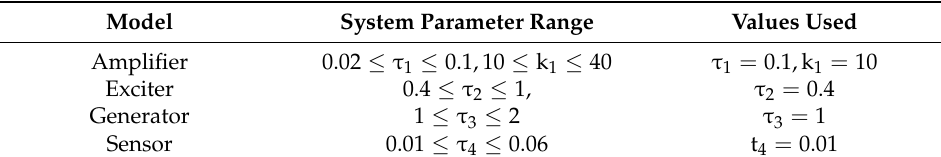
Table 2. Parameters of the AVR system under study.